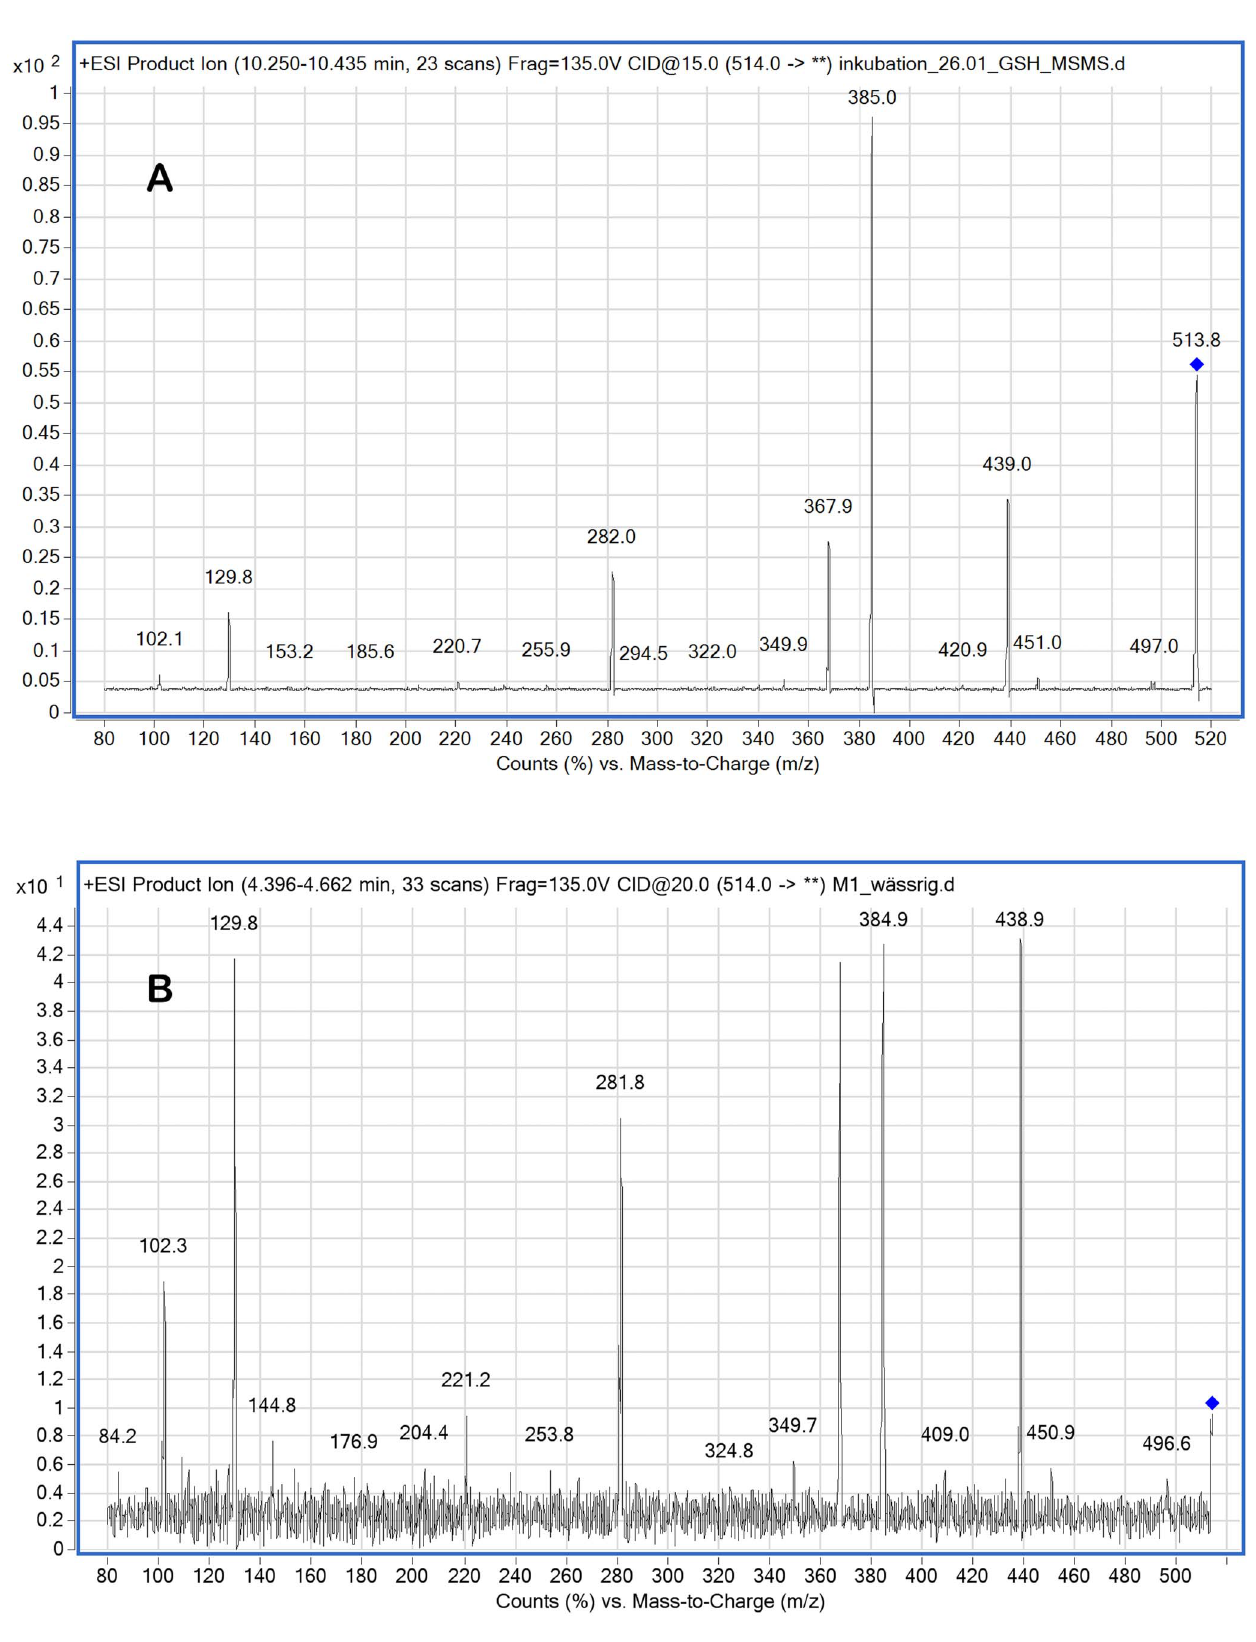
Figure 5. MS/MS spectra of the M1-glutathione adduct. A : MS/MS spectrum of the putative M1-glutathione adduct with [M + H] + m/z of 514 found in the erythrocyte lysate after incubation with the metabolite M1. B : MS/MS spectrum of the M1-glutathion adduct with [M + H] + m/z of 514 obtained after incubation of the metabolite M1 with glutathione and glutathione-S-transferase. Characteristic fragments for glutathione are